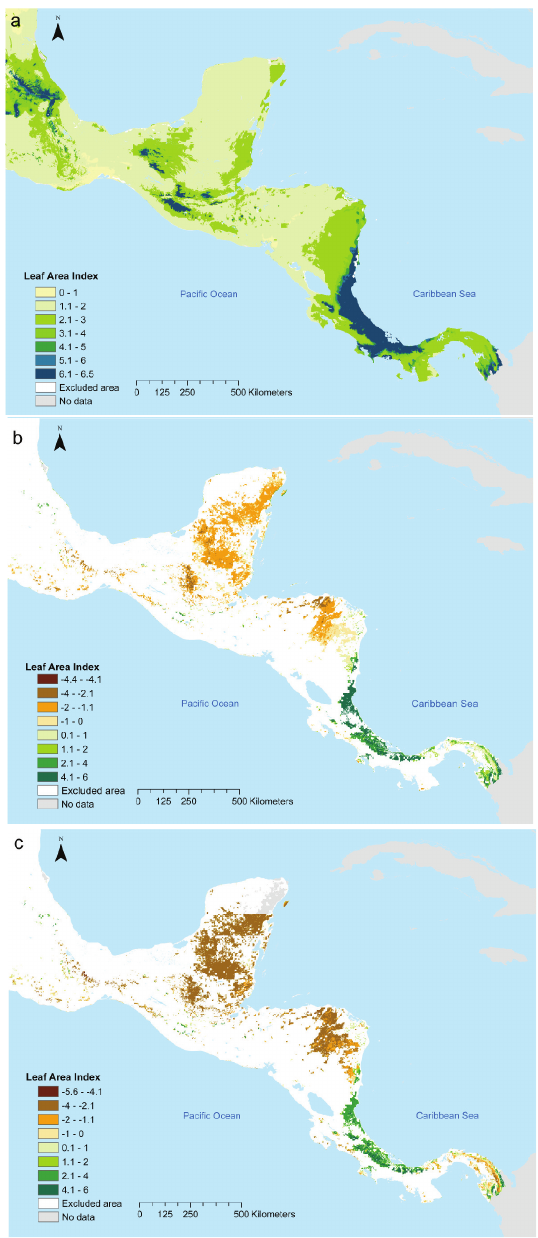
960 Fig. 4. Validation of MAPSS LAI output: (a) LAI modeled by MAPSS, (b) and (c) 961 difference between LAI simulated by MAPSS and the MODIS and GLOBCARBON 962 global satellite products, respectively. White areas were excluded due to land cover 963 Fig. 4. Validation of MAPSS LAI output: (a) LAI modelled by characteristics criteria. MAPSS LAI represents an average LAI based on 30–50 year 964 MAPSS, (b) and (c) difference between LAI simulated by MAPSS climate averages, while MODIS is the LAI average between 2000 and 2009, and 965 and the MODIS and GLOBCARBON global satellite products, re- GLOBCARBON between 1998 and 2007. 966 spectively. White areas were excluded due to land cover character- istics criteria. MAPSS LAI represents an average LAI based on 30– 50 year climate averages, while MODIS is the LAI average between 2000 and 2009, and GLOBCARBON between 1998 and